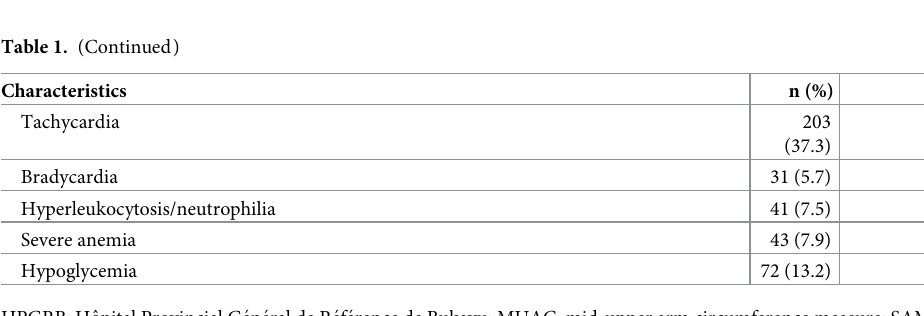
PLOS ONE | https://doi.org/10.1371/journal.pone.0236022 July 17,